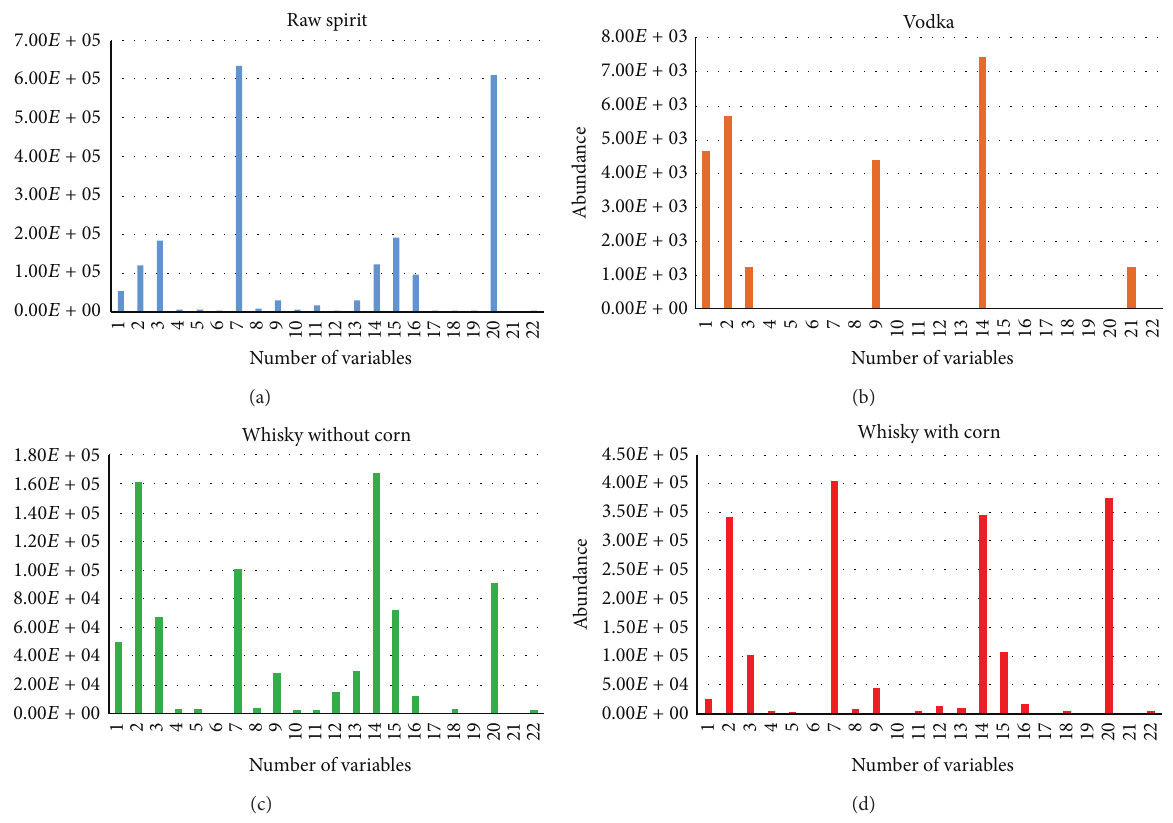
Figure 2: Mean bar graphs of selected peak areas used as raw data in chemometrics representing key chemical compounds, which are important for discrimination of (a) raw spirit, (b) vodka, (c) whisky without corn, and (d) whisky with corn.